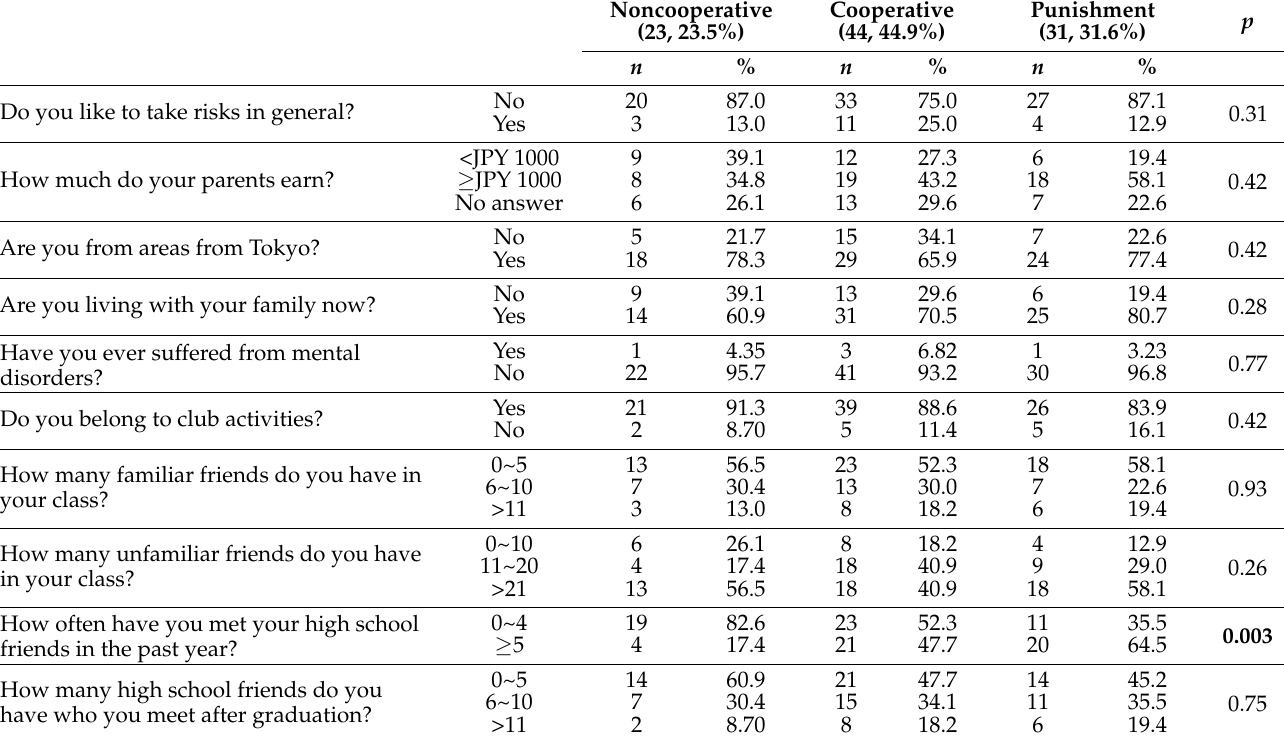
Table 2. Sharing tasks with an unfamiliar classmate (reference: